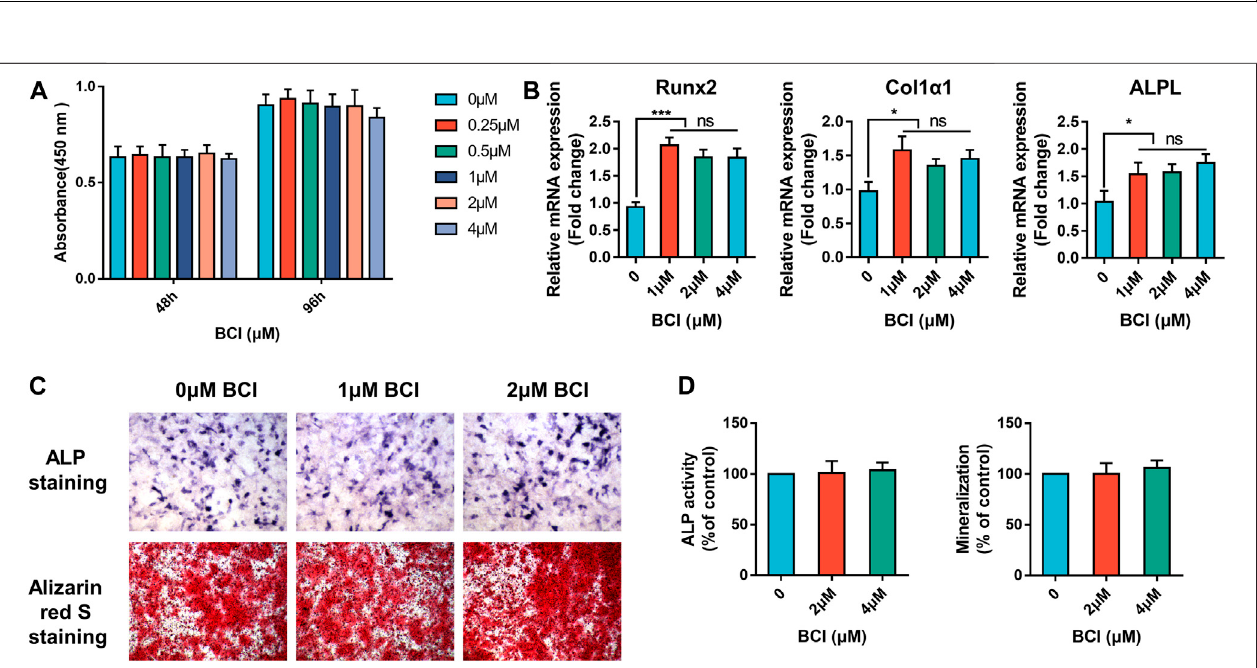
FIGURE 7 | BCI does not affect osteogenic differentiation or mineralization. (A) CCK-8 evaluation of MC3T3-E1 cell viability following treatment with or without variousdosesofBCIfor48and96 h (B) qRT-PCRanalysisofmRNAlevelsofkeyosteogenicdifferentiationgenes(RUNX2,COL1 α 1,andALPL)followingBCItreatment. (C,D) Representative images of ALP and mineralization activity and corresponding quanti fi cation results in MC3T3-E1 cells induced by osteogenesis-inducing fl uid and treated with or without different doses of BCI.